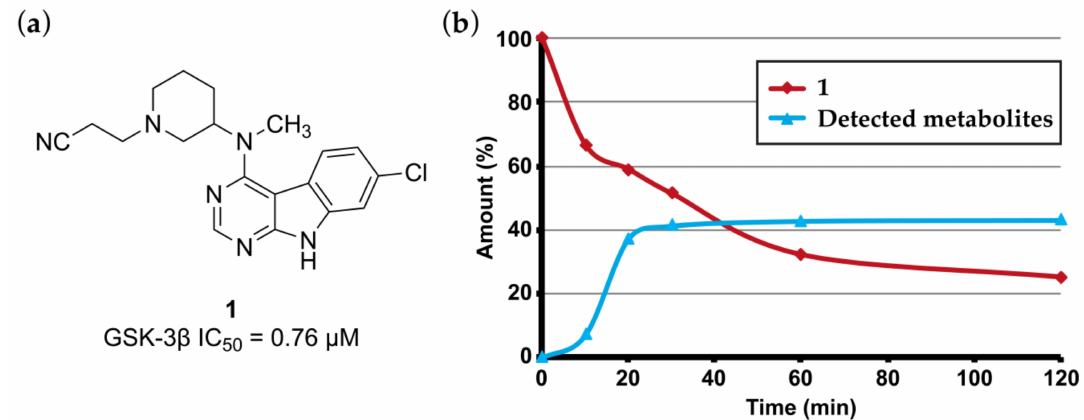
Figure 1. ( a ) Structure and biological activity of compound 1; ( b ) metabolic degradation and formation of detected metabolites of 1